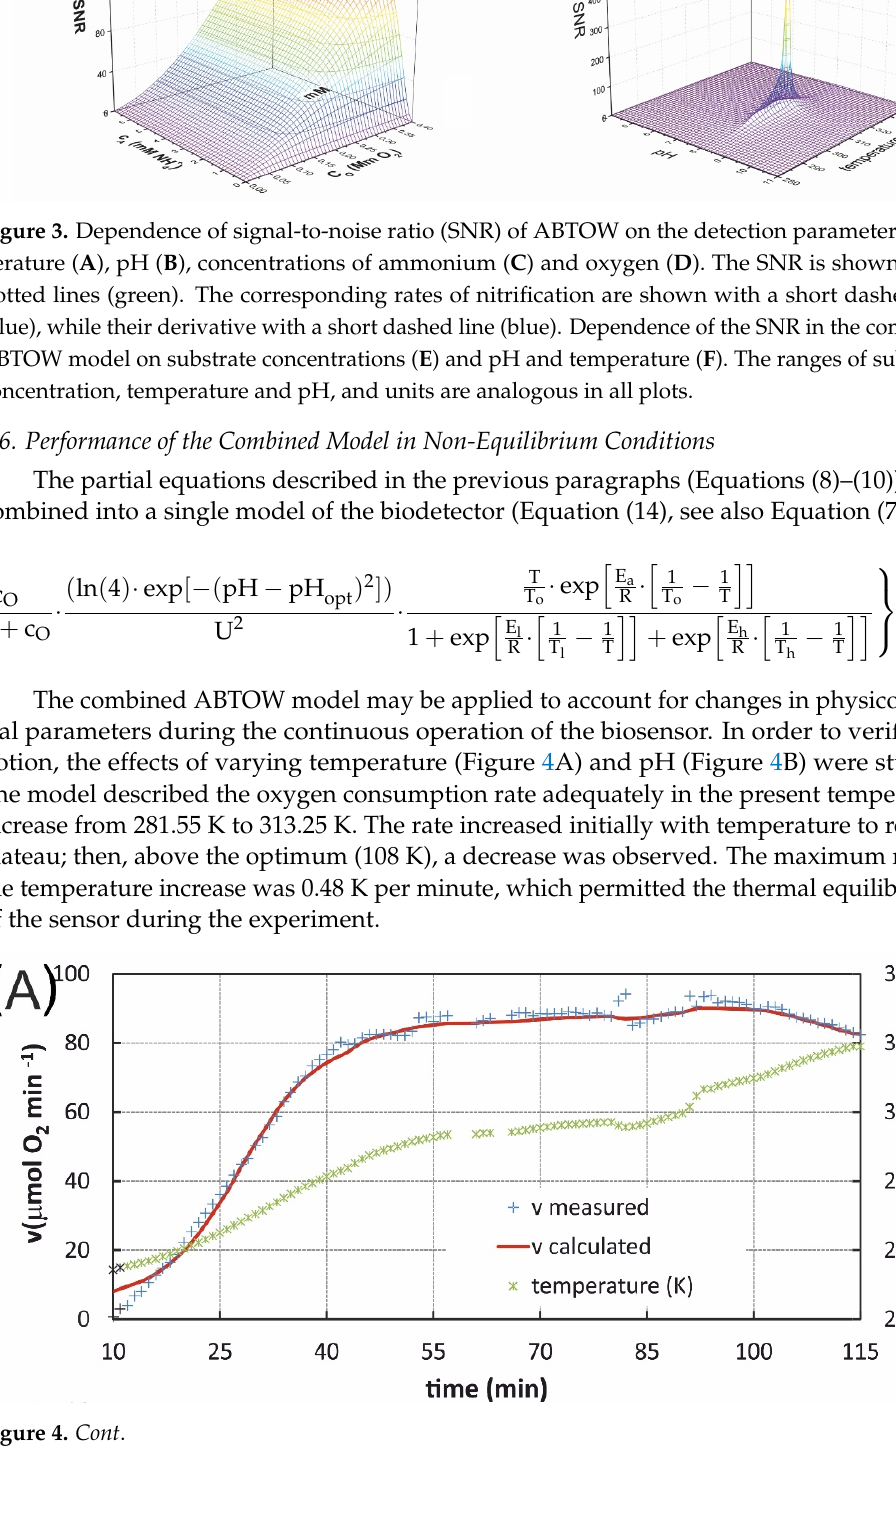
Figure 4. Performance of the ABTOW model in non-equilibrium conditions. Effects of temperature increase ( A ) and stepwise pH changes ( B ). Oxygen consumption (left Y-axis) and parameters (right Y-axis) are plotted against time (X-axis). Model prediction (red line) and experimental data (blue symbols) are plotted together with temperature ( A , light green symbols) or pH ( B , green line). Likewise, the model correctly described the response of ABTOW to stepwise changes in pH (3–9.5) (Figure 4B). It may be noted that following pH change, oxygen consumption rate ABTOW reached a stable level after approximately 1.5 min. Therefore, it may be pos- tulated that pH buffering contributes to the inertia of ABTOW, limiting its response ve- locity. All estimated parameters of the ABTOW model are summarized in Table 1.